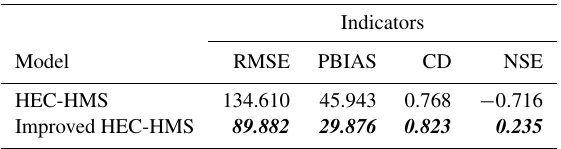
Table 4. Uncalibrated HEC-HMS model result comparisons. Bold italic font indicates a better